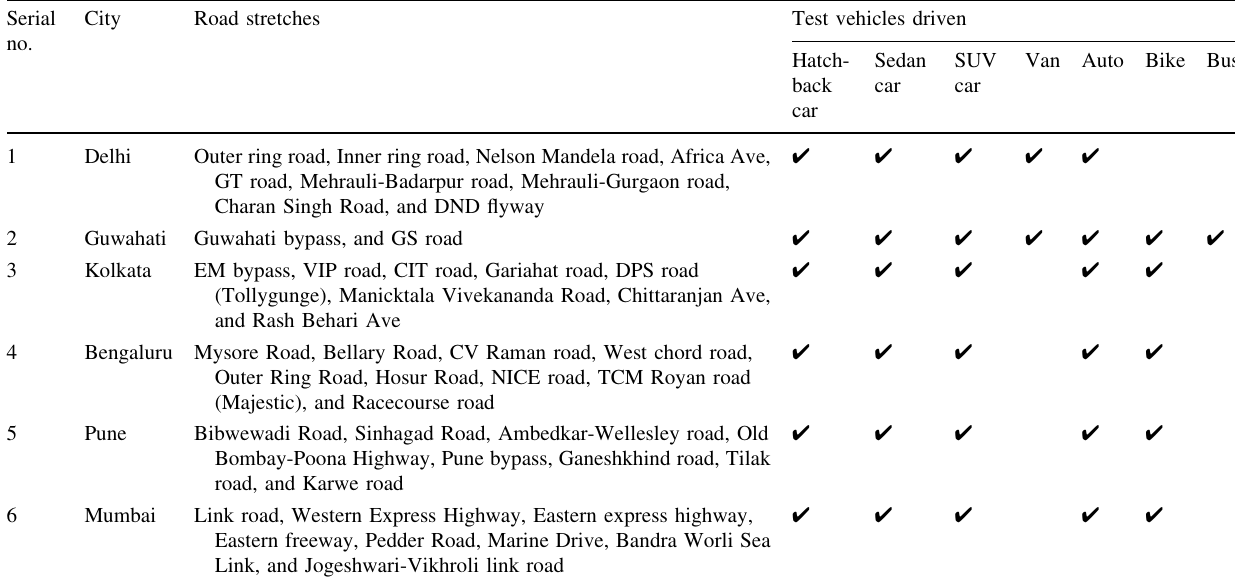
Table 1 Details of road stretches and test vehicles used in field data collection in different cities Serial